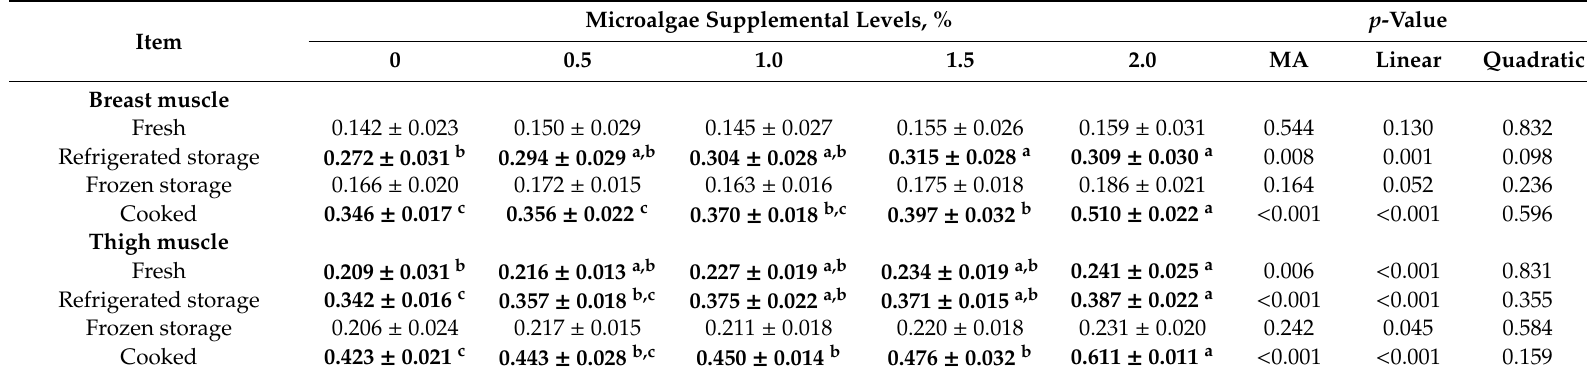
Table 7. The biomarkers (TBARS, mg MDA / kg fresh meat) of lipid oxidation of fresh, refrigerated, frozen, and cooked meat from laying hens with graded levels of Aurantiochytrium sp.